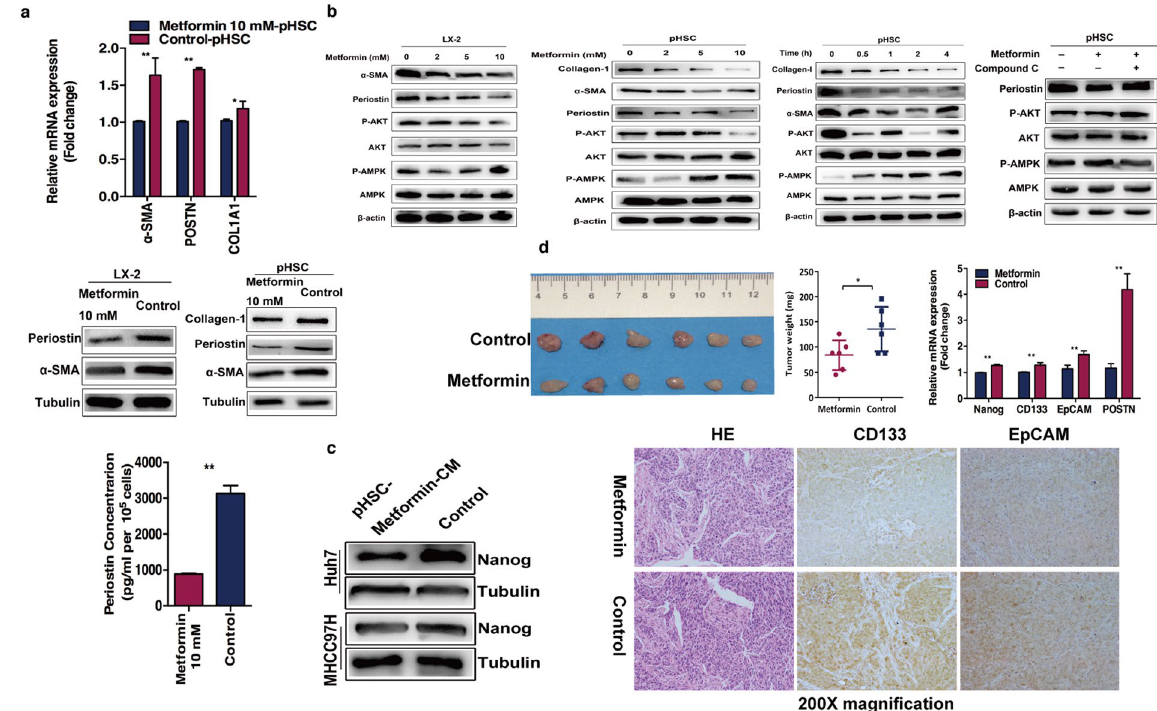
Figure 5. Metformin suppressed tumor progression of heat-exposed residual HCC cells by inhibiting POSTN secretion from activated HSCs and down-regulation of cancer stem cell markers. ( a , b , c ) Metformin inhibited α -SMA, collagen type 1 alpha 1 (COL1A1) and POSTN mRNA expression in the activated HSCs and decreased the supernatant concentration of POSTN in the HSC-CM. Quantitative RT-PCR and ELISA were performed. POSTN were down-regulated by metformin in dose- and time-dependent manner through p-AMPK activation and p-AKT inhibition, which was reversed by AMPK inhibitor Compound C. Western blots were performed. Nanog expression was decreased in residual MHCC97H and Huh7 cells co-cultured with CM from metformin- treated pHSCs (primary human hepatic stellate cells) compared to with control medium. ( d ) Heat-exposed residual MHCC97H cell co-inoculated with pHSCs subcutaneously in the right flank of nude mice (n = 6 mice per group). The in vivo tumor growth generated from heat-exposed residual HCC cells with activated HSCs was significantly inhibited in the metformin-treated group. The lower expression of Nanog, CD133, EpCAM and POSTN in the metformin-treated tumors was detected by quantitative RT-PCR and immunohistochemical analysis. ** P < 0.01; * P <